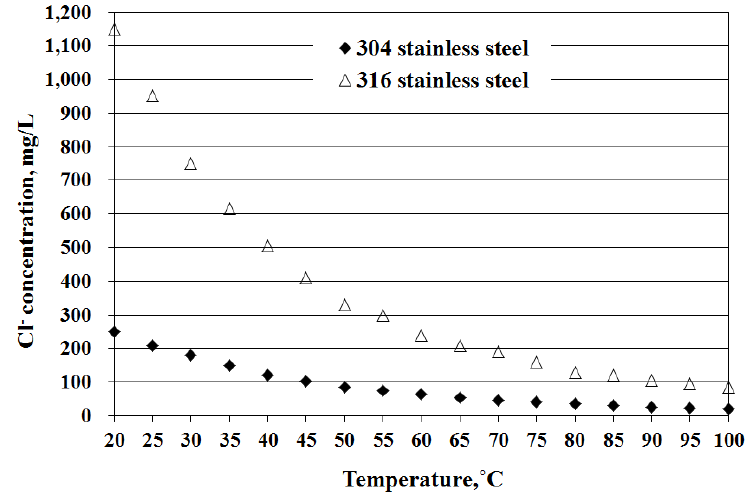
Figure 3. Relationship of concentration limits for stainless steel corroded by chloride ions at pH = 7 versus temperature (compiled from the study of Huang and Huang [23]).